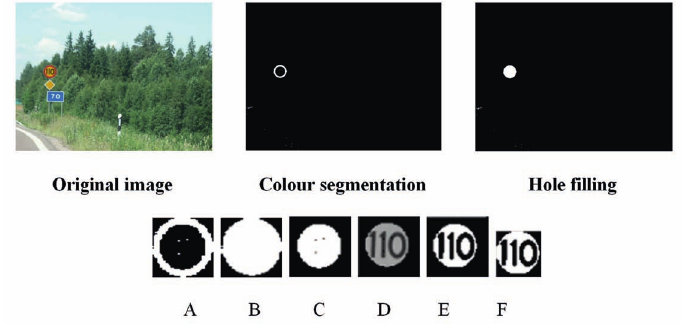
Figure 2. Steps to extract a candidate traffic signs from the